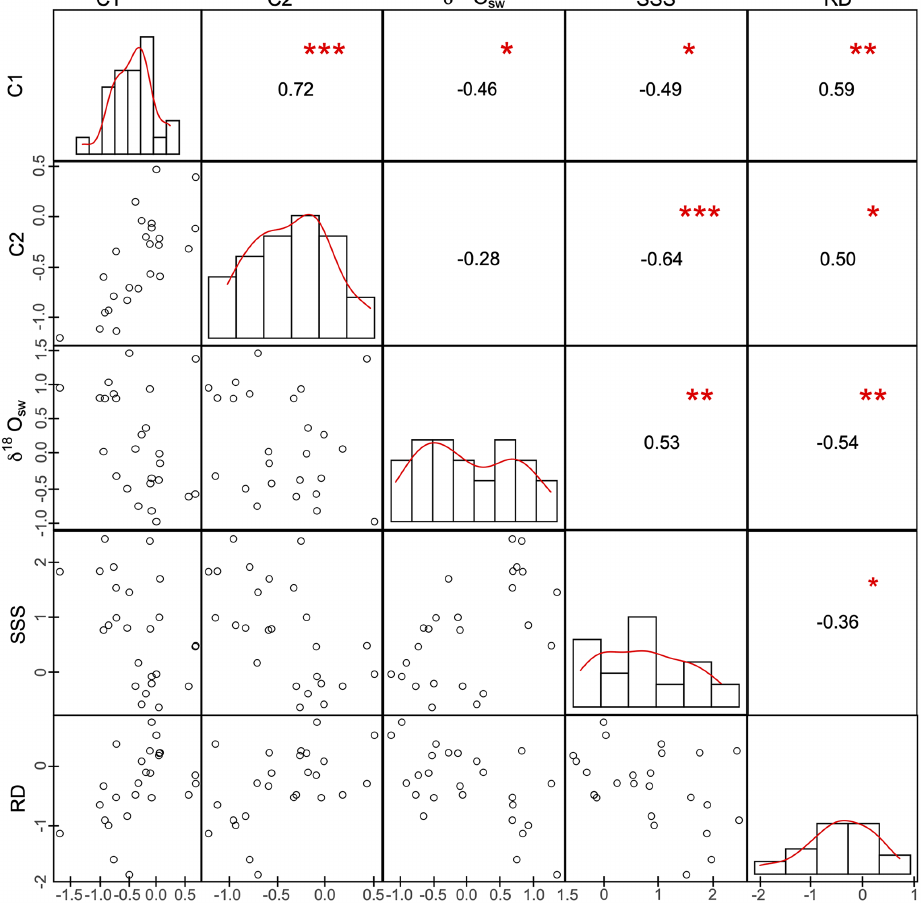
Figure 4. Correlation matrix between annual standardized coral core-derived proxies for sediment (C1, C2, both Ba / Ca composites) and freshwater ( δ 18 O sw , AG1–2 record) discharge with instrumental data for river discharge (RD) and salinity (SSS) across 1990 to 2015. The distribution of each variable is in the centre (as a frequency ranging from 0 to 1), the bivariate scatter plot using standardized units under the diagonal, and the value of the correlation as well as significance of the p value as symbols (“ ∗∗∗ ”, “ ∗∗ ”, “ ∗ ”, “.”, “ ” as p values of 0 and under 0.001, 0.01, 0.05, and 0.1, respectively) over the